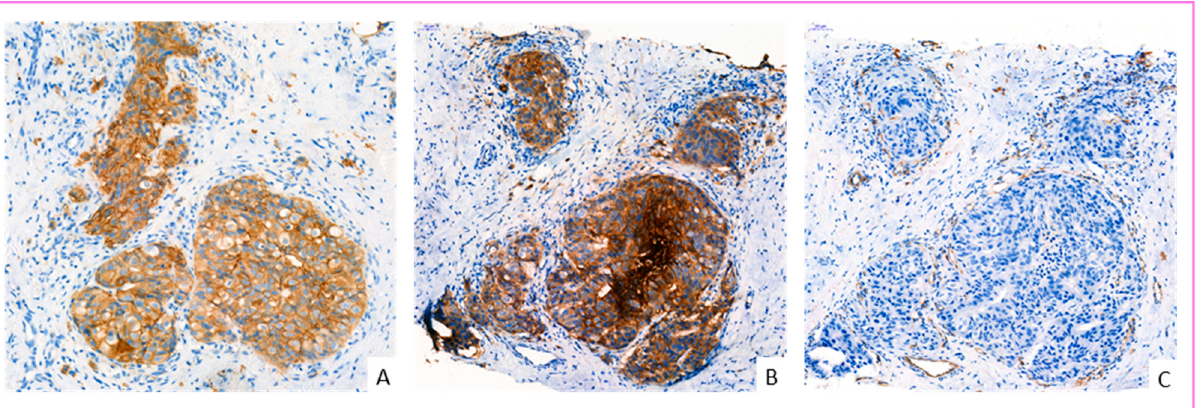
Figure 6. Spatial comparison between GLUT-1 and HER2 overexpressed cancer cells, and the vascular marker CD31 by immunohistochemistry on the same breast cancer section. ( A ) This image shows overexpression of breast cancer cells by HER2 (score 3+). ( B ) The same cancer cells overexpress GLUT-1 (score 3). ( C ) This image shows neoangiogenesis and vascularization of the tumor stroma by CD31. The new vessels are located very close to the invasive carcinoma clusters (magnification ×200).